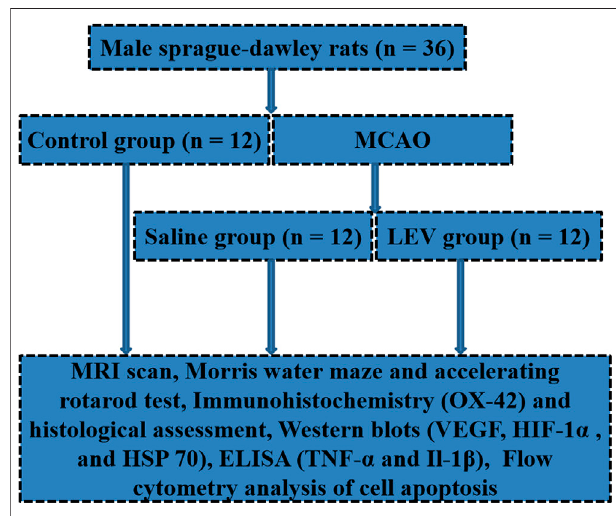
FIGURE 1 | Schematic of the study design, including all